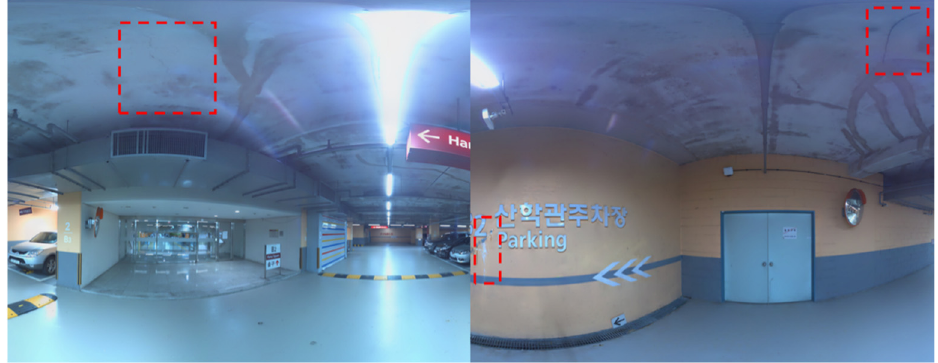
Figure 10. Acquired image from scanning for visual